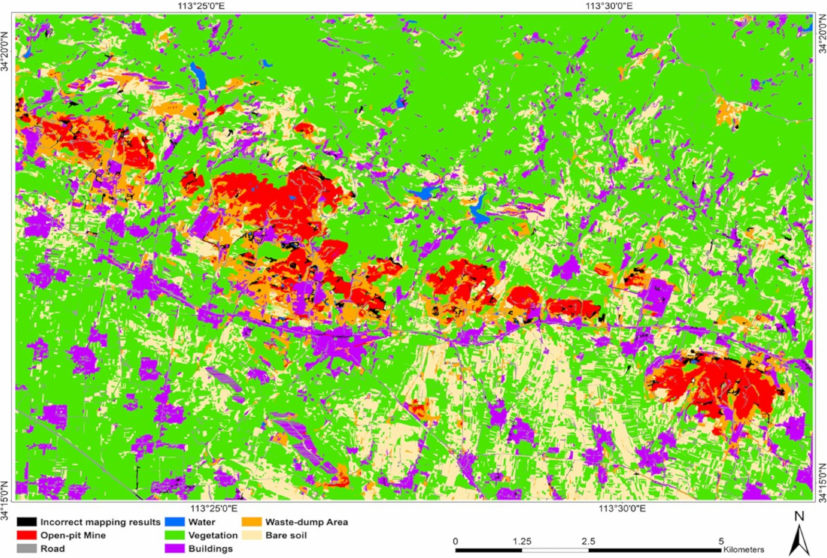
Figure 13. Results of LUCs identification and incorrect identifications of